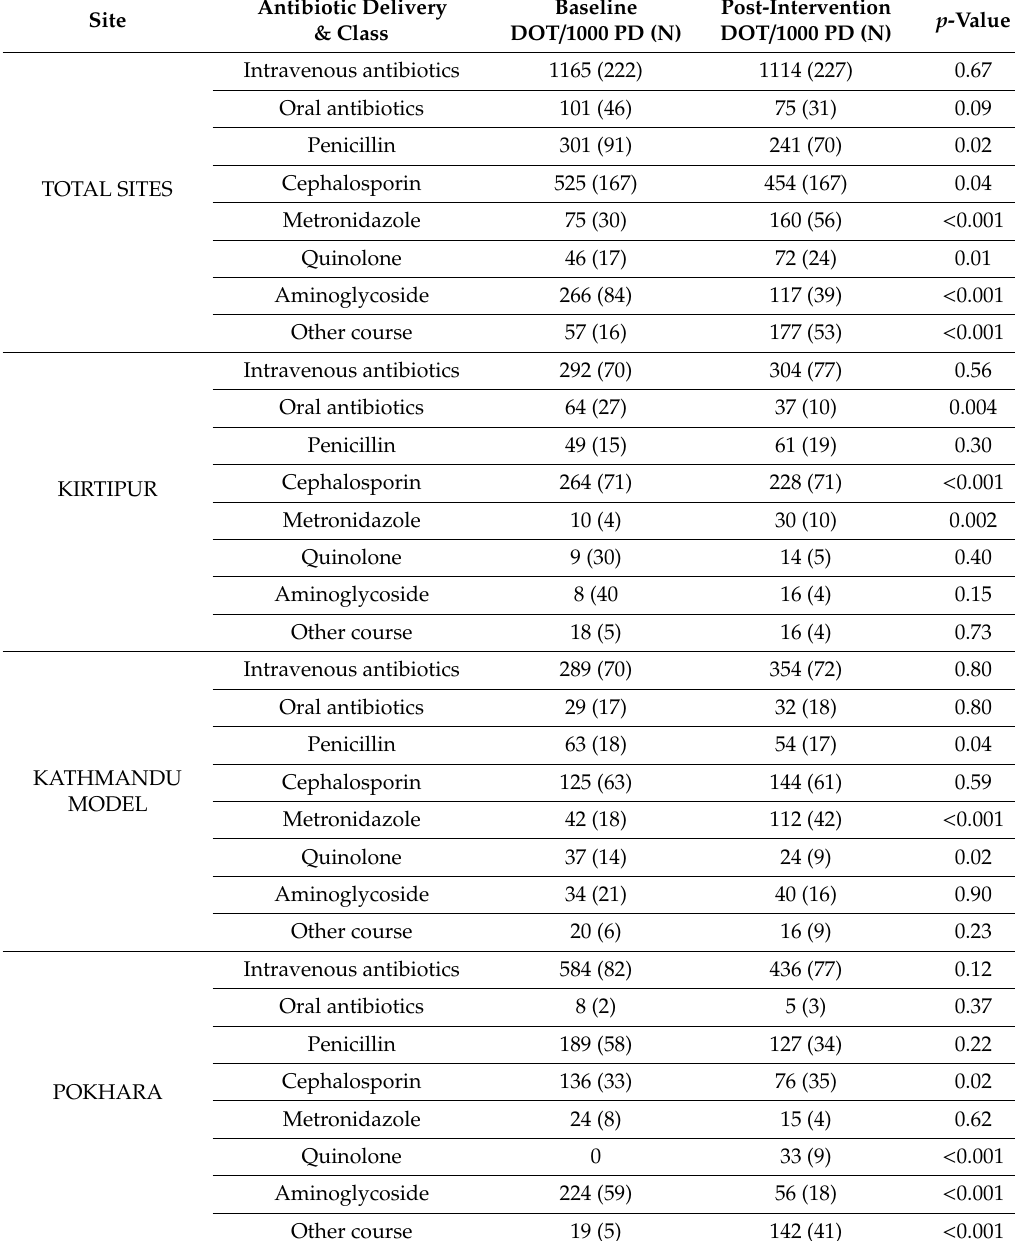
Table 2. Days of therapy (DOT) per 1000 patient-days (PD) of prescribed antibiotics at baseline and post-intervention periods total and by study sites (Kirtipur, Kathmandu Model, and Pokhara